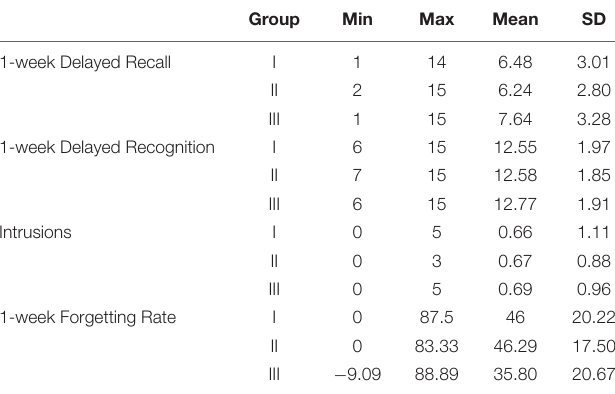
TABLE 12 | Performance on LTF